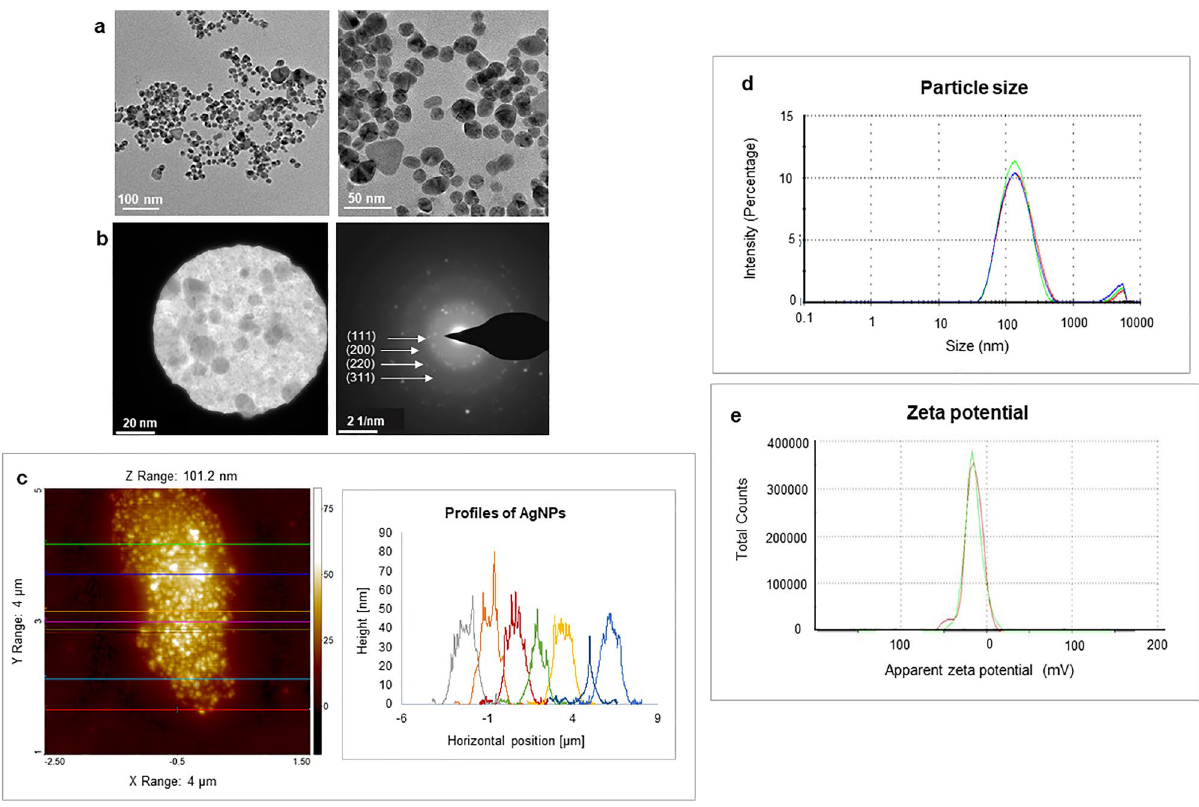
Figure 4. ( a ) Transmission electron microscopy images of produced AgNPs—nanoparticles shape and ( b ) selected area (electron) diffraction (SAED) with respective apertures. ( c ) AFM analysis of nanoparticles ( d ) Particles size distribution concerning the intensity of AgNPs and ( e ) zeta potential distribution showed the negative zeta potential value. The study was done in triplicates, and the results are an average of three analyses.